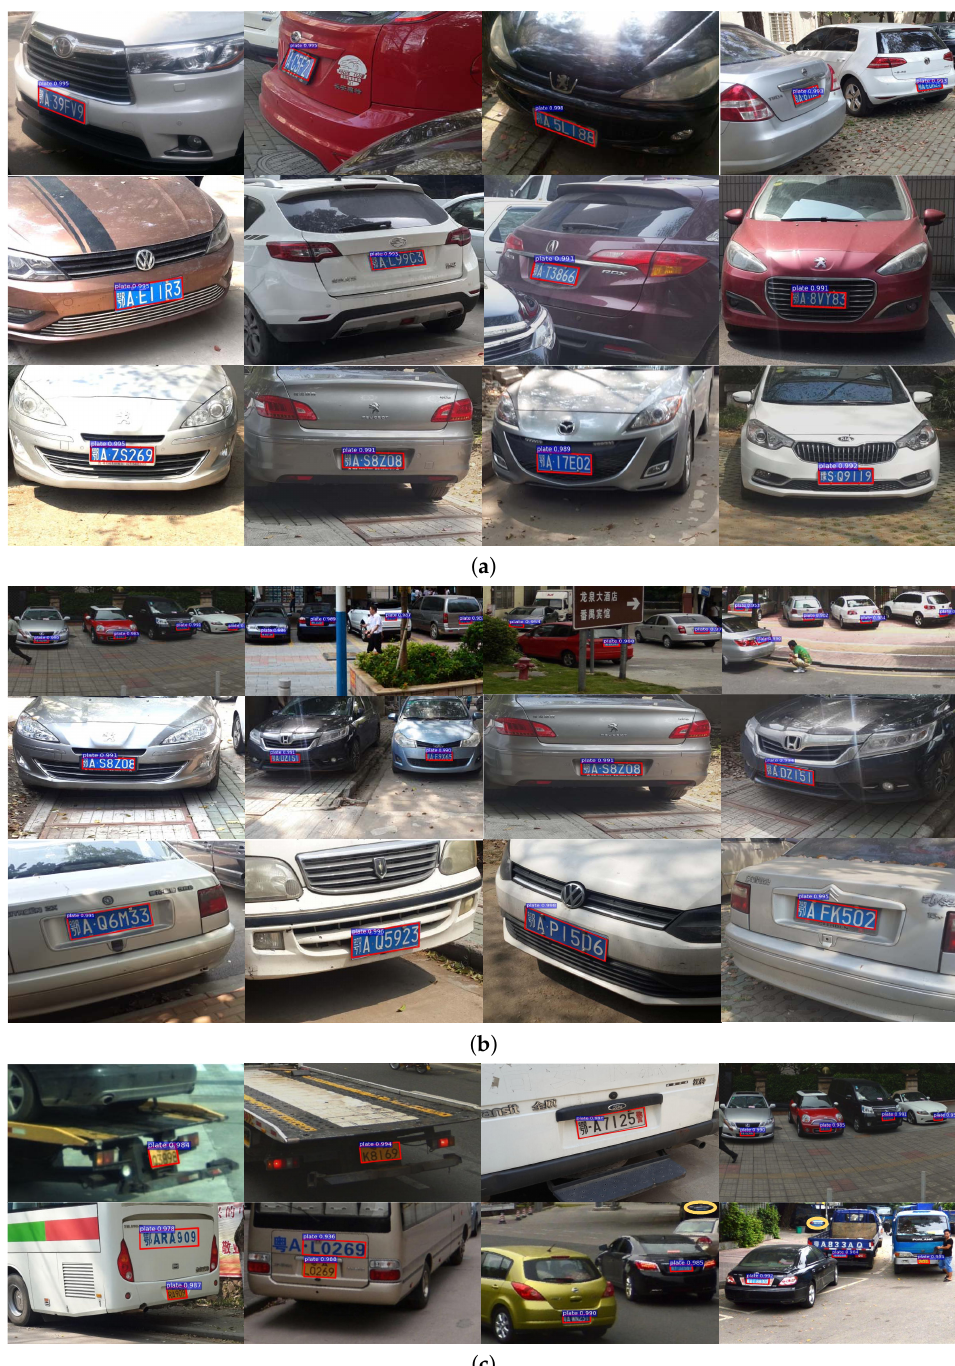
Figure 4. Some representative detection results of our MOSI-LPD : ( a ) results on license plates with different orientations (skewing violently, modestly and slightly for each row); ( b ) results on license plates with multiple scales (tiny, medium, and large in scale for each row); ( c ) results on special or low-resolution license plates in the first row, and scarce cases of mistaking or missing of license plates (indicated by yellow ellipses) in the second